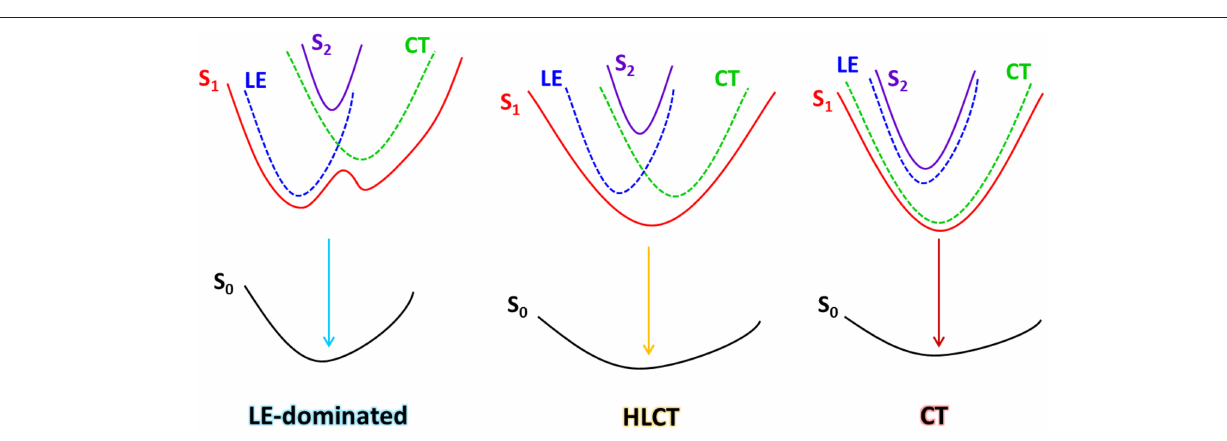
SCHEME 1 | Schematic diagram of interaction between LE and CT excited